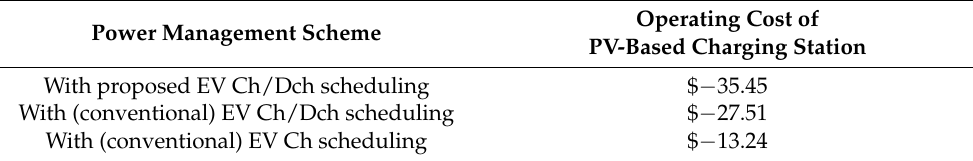
Table 2. Comparison of operating cost of PV-based charging station according to power scheduling scheme.